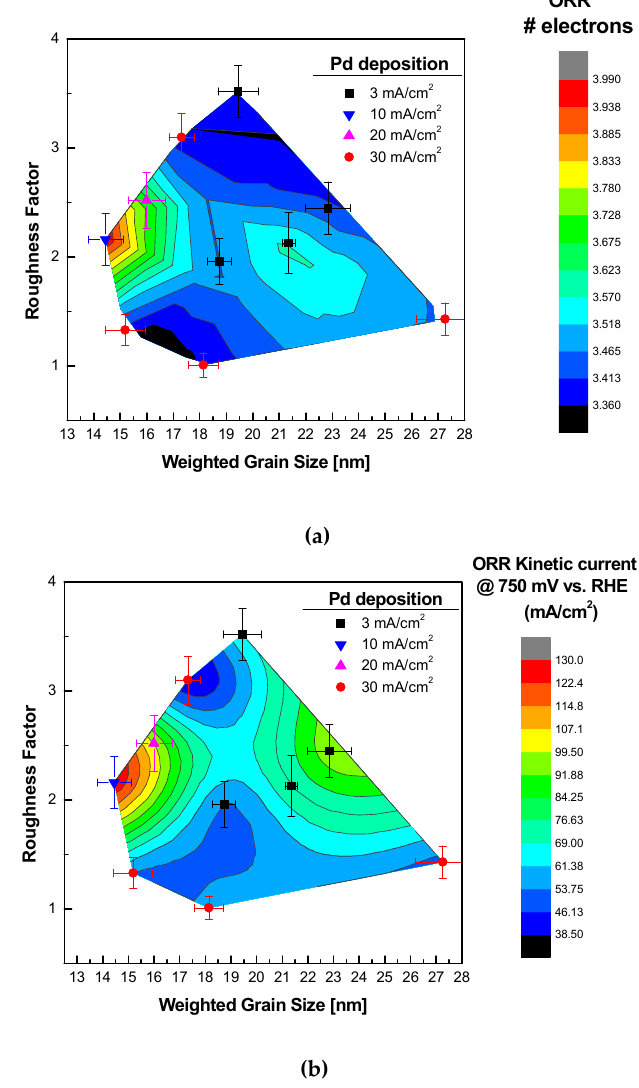
Figure 4. (a) Number of electrons transferred and (b) kinetic current density and number of electrons at 750 mV vs. RHE as function of the weighted grain size and roughness factor. at 750 mV vs. RHE as function of the weighted grain size and roughness